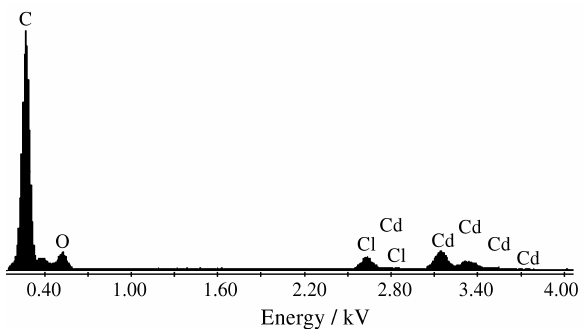
Figure 5. EDS analysisofthe RVC-PPy 0 electrode showing the presence of Cd.